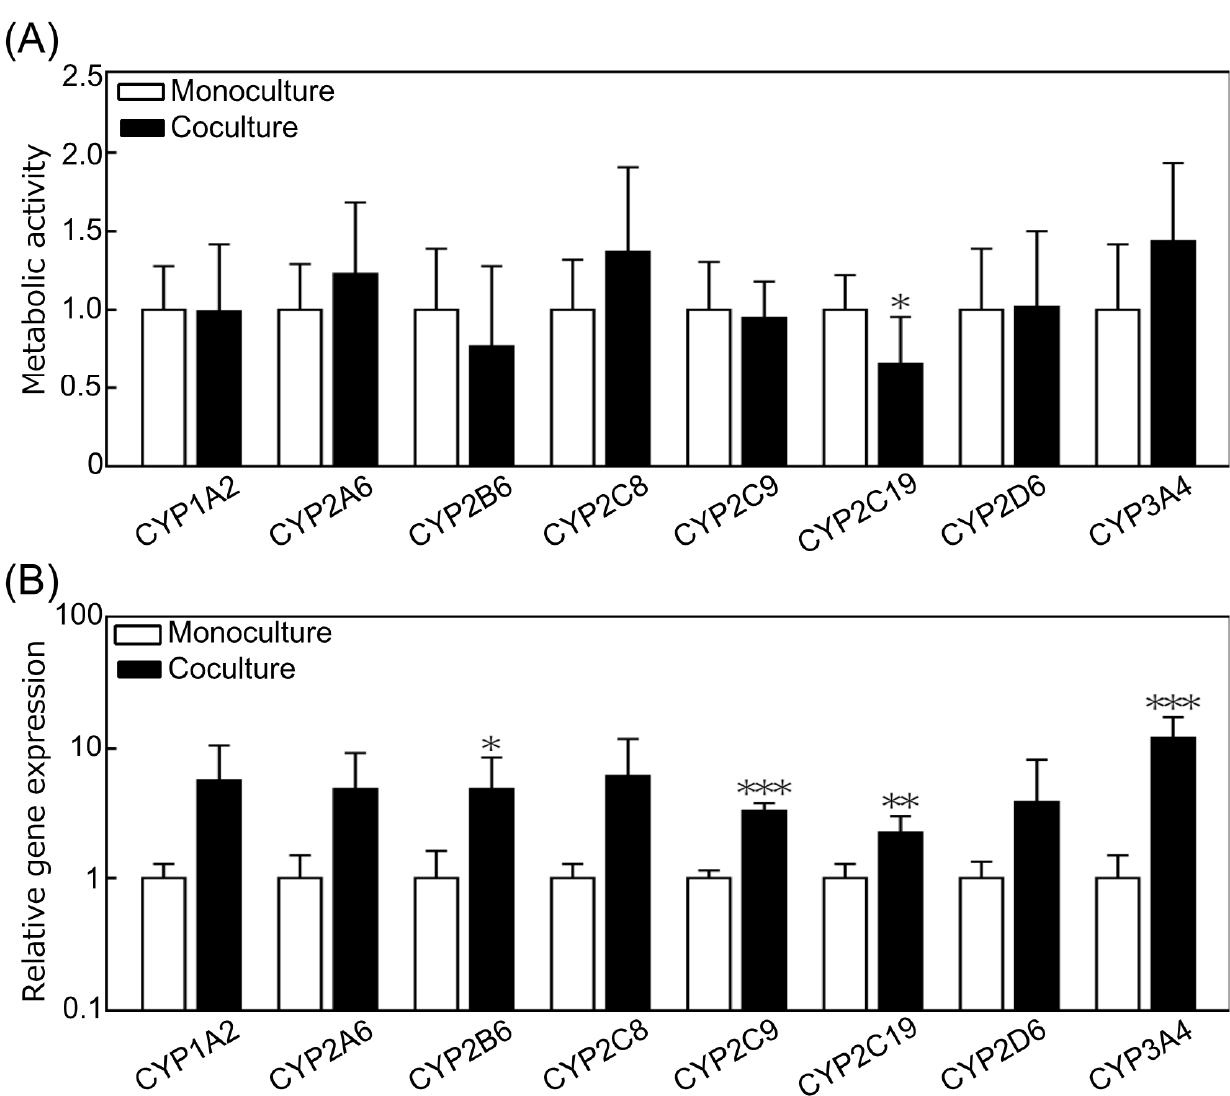
Figure 5. Evaluation of the coculture effects on the metabolic function of primary hepatocytes derived from chimeric mice with humanized liver tissues (PXB cells). ( A ) Metabolic activity of PXB cells normalized by monoculture using liquid chromatography–tandem mass spectrometry (LC-MS/MS). The metabolic activity of CYP2C19 was significantly decreased by coculture ( n = 5–8). ( B ) The relative gene expression levels related to the metabolism of PXB cells tended to increase in coculture. Significant differences were observed in the expression levels of CYP2B6, 2C9, 2C19, and 3A4 ( n = 7–18). Each value was normalized to that of the monoculture for each gene. Data represent the mean ± SD, * p < 0.05, ** p < 0.01, and *** p < 0.005.